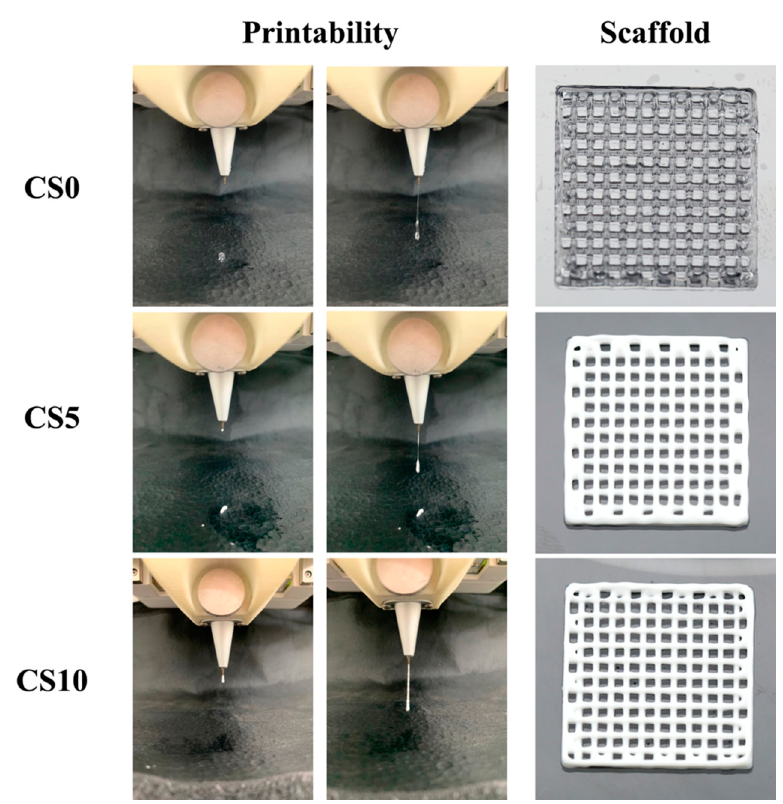
Figure 4. Printability test of CS/GelMa bioinks and the photo image of the fabricated 3D scaffold.